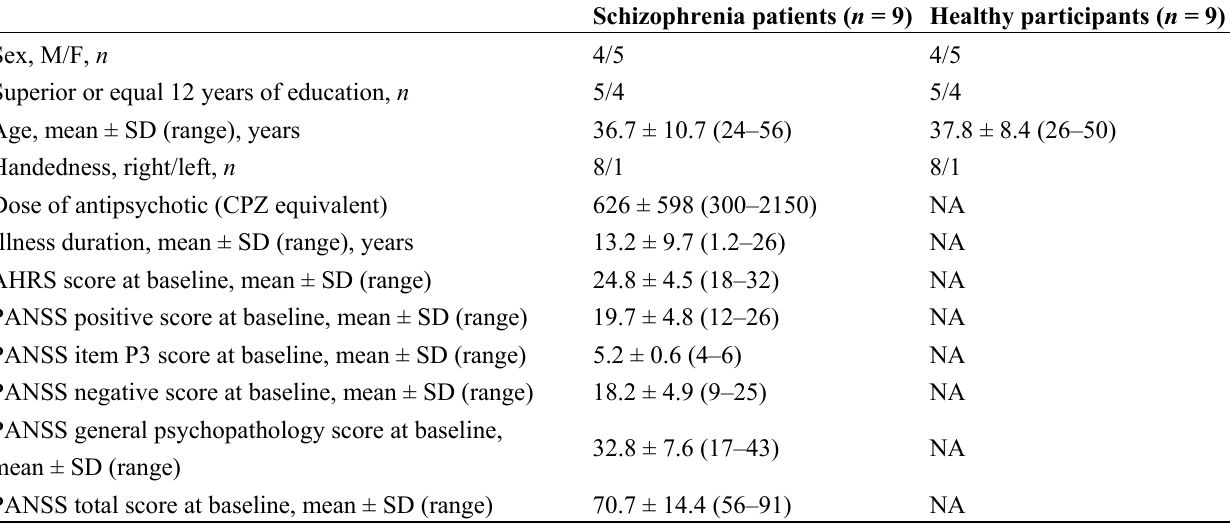
Table 1. Sociodemographic and clinical characteristics of the study groups. AHRS, Auditory Hallucination Rating Scale; PANSS, Positive and Negative Symptom Scale; NA, not